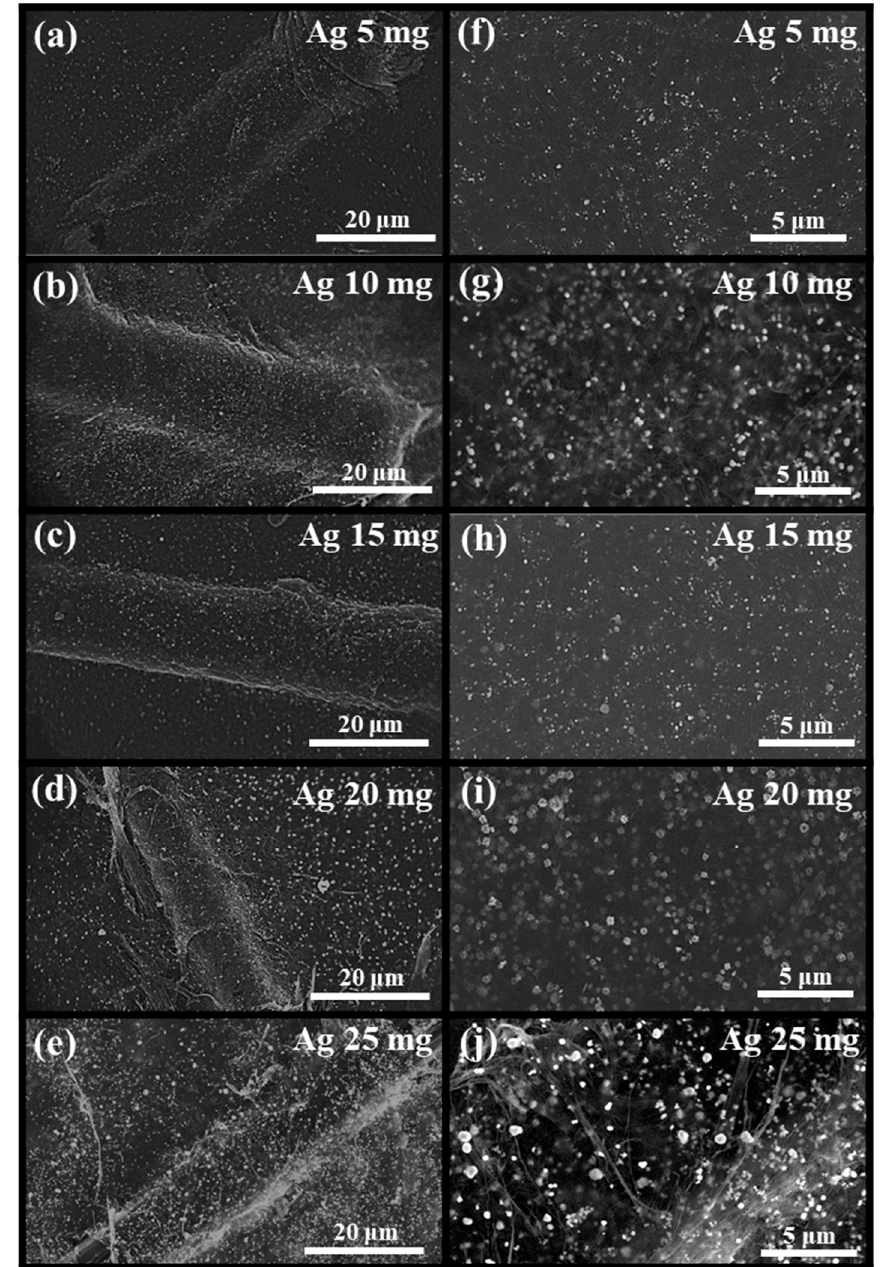
Figure 7. HR-SEM images of the FWCNT-MPCF-Ag hybrid films incorporated with different Ag contents of: ( a ) and ( f ) 5 mg (9.1 wt %), ( b ) and ( g ) 10 mg (16.6 wt %), ( c ) and ( h ) 15 mg (23.0 wt %), ( d ) and ( i ) 20 mg (28.6 wt %), and ( e ) and ( j ) 25 mg (33.3 wt %) (MPCF length: 6 mm; MPCF content: 30 mg; FWCNT content: 20 mg; ultrasonication for 0.5 h). ( a ) to ( e ) are low-magnification images, while ( f ) to ( j ) are high-magnification images.